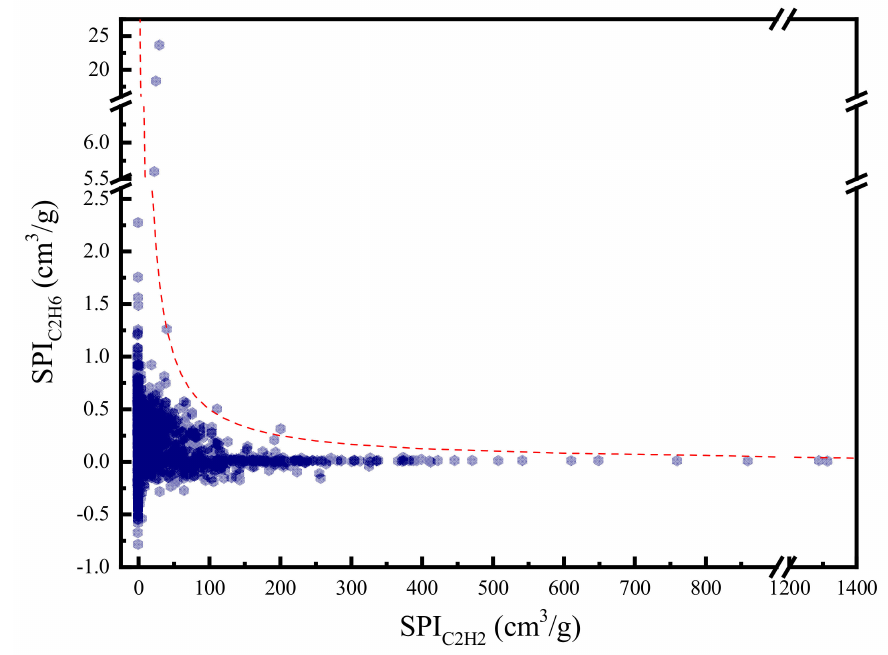
Figure 4. C 2 H 2 /C 2 H 4 separation performance versus C 2 H 6 /C 2 H 4 separation performance (The red dash line: SPI = 50).